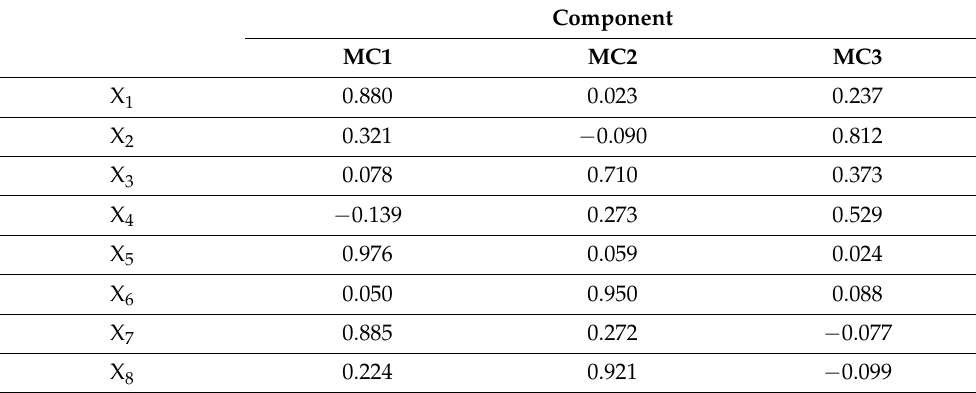
Table 2. Matrix of factor